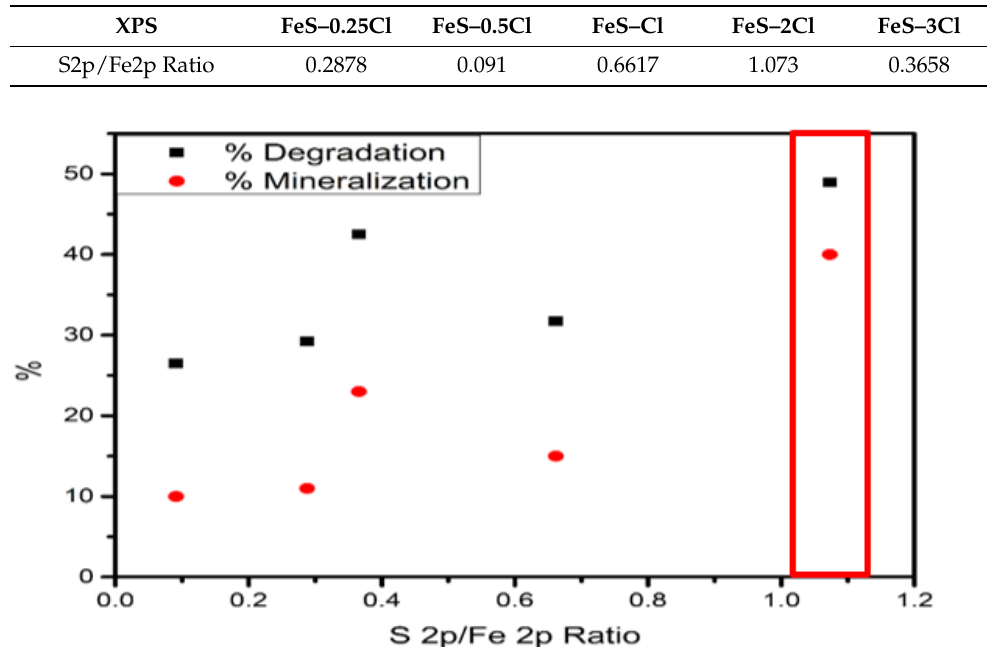
Table 11. Oxide-band-gap to sulphide-band-gap